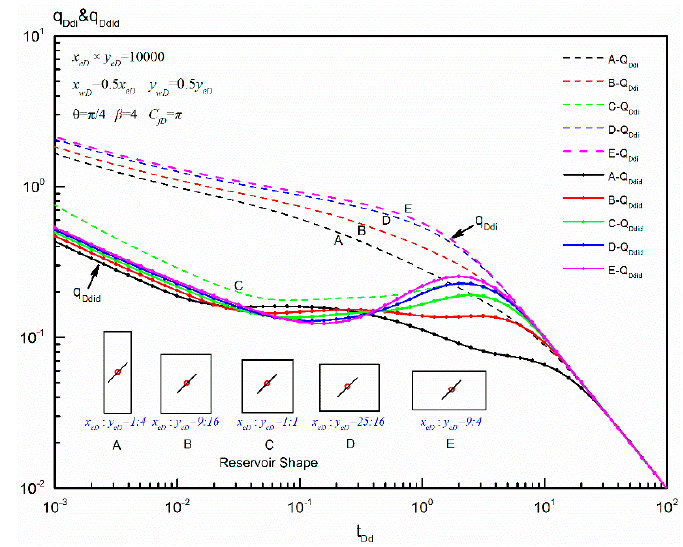
Figure 16. Blasingame format curves for a fractured well in an anisotropic rectangular reservoir at different reservoir shapes. di ff erent reservoir